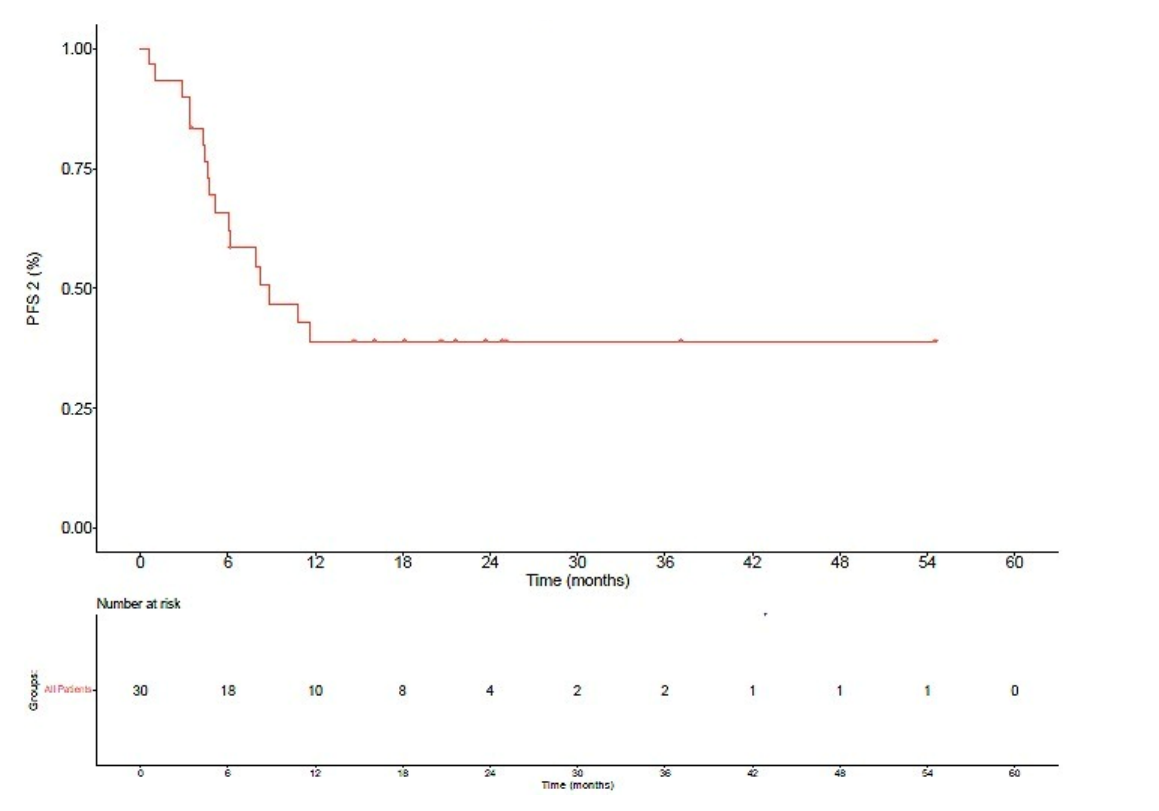
Figure 2. PFS2 among all oligoprogressors who received radiation therapy.